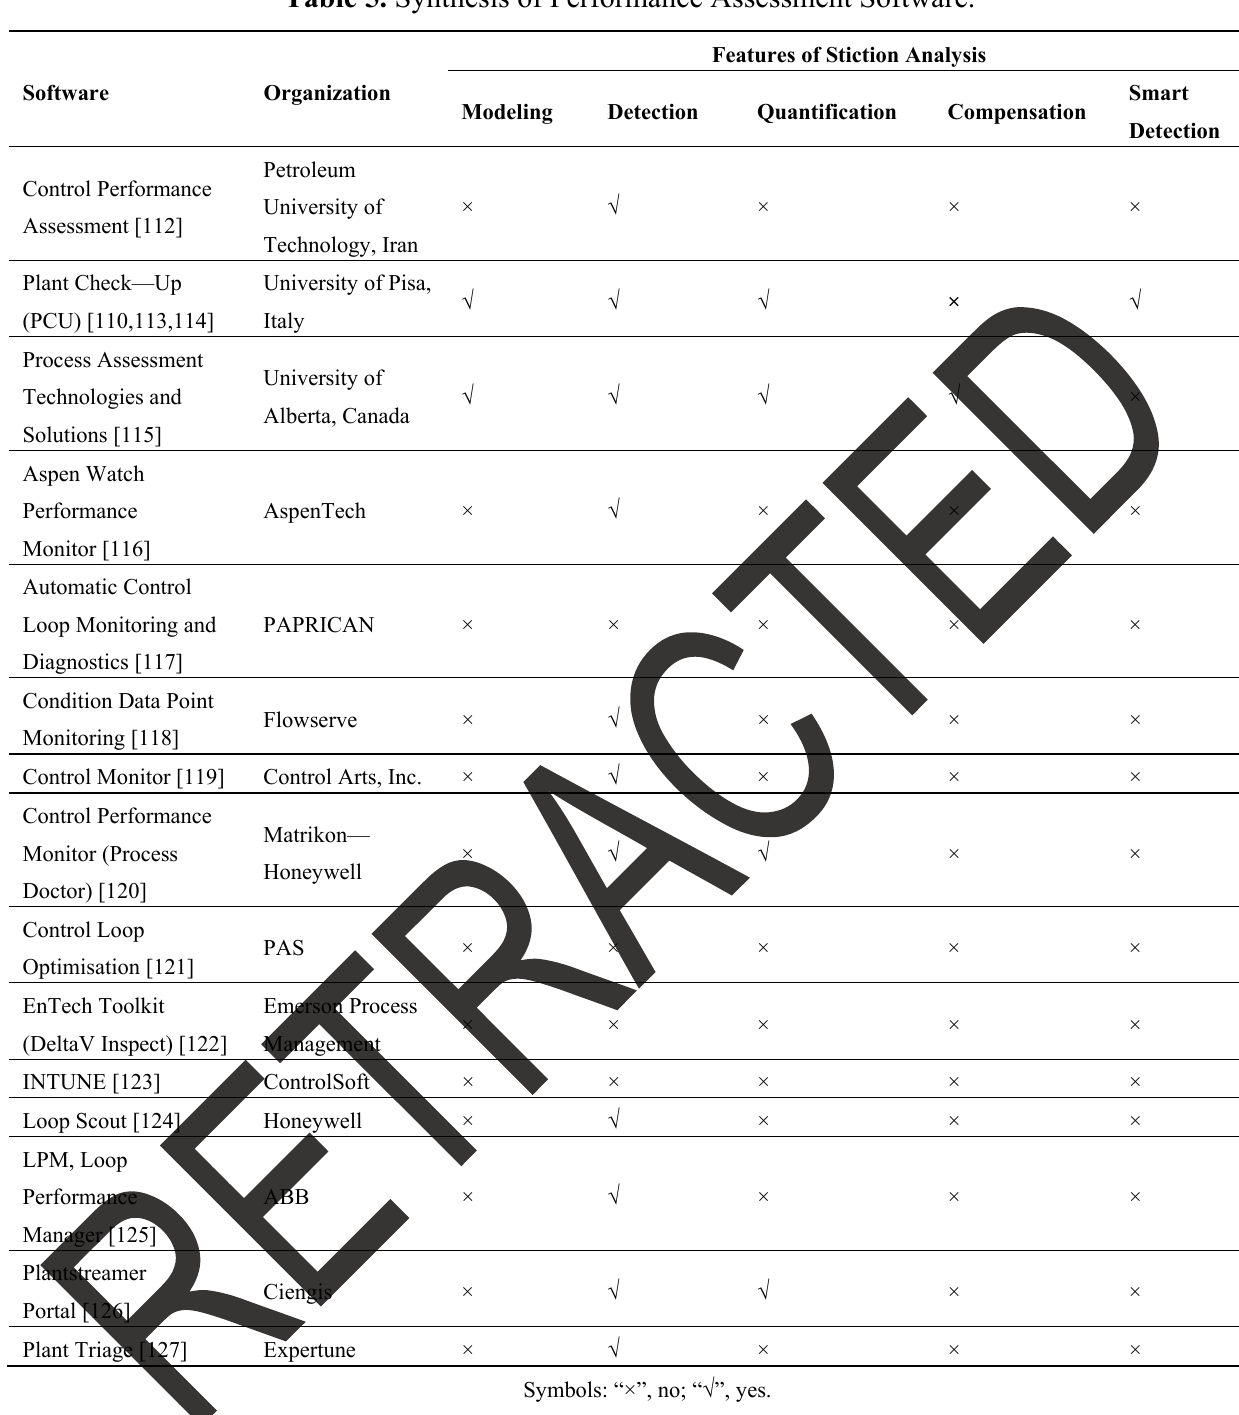
Table 5. Synthesis of Performance Assessment